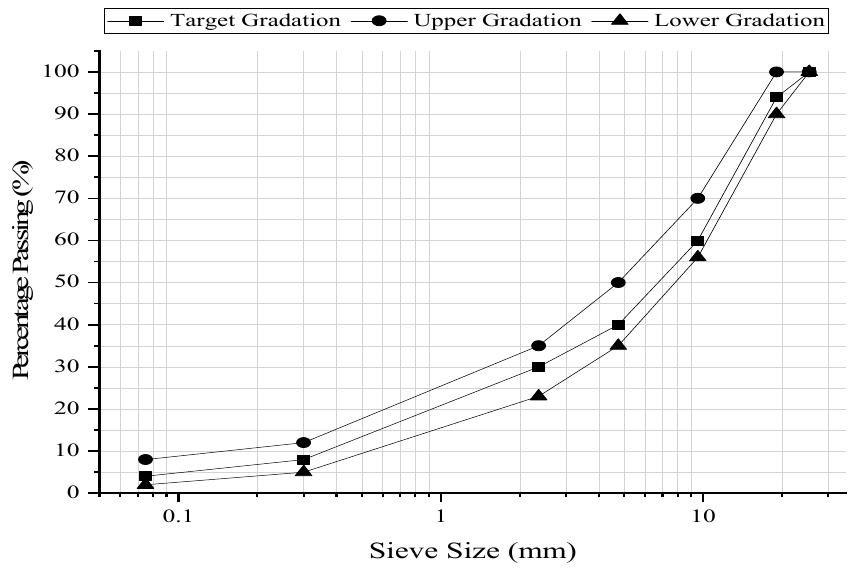
Figure 2. Gradation curve. Table 2. Chemical composition of aggregates .